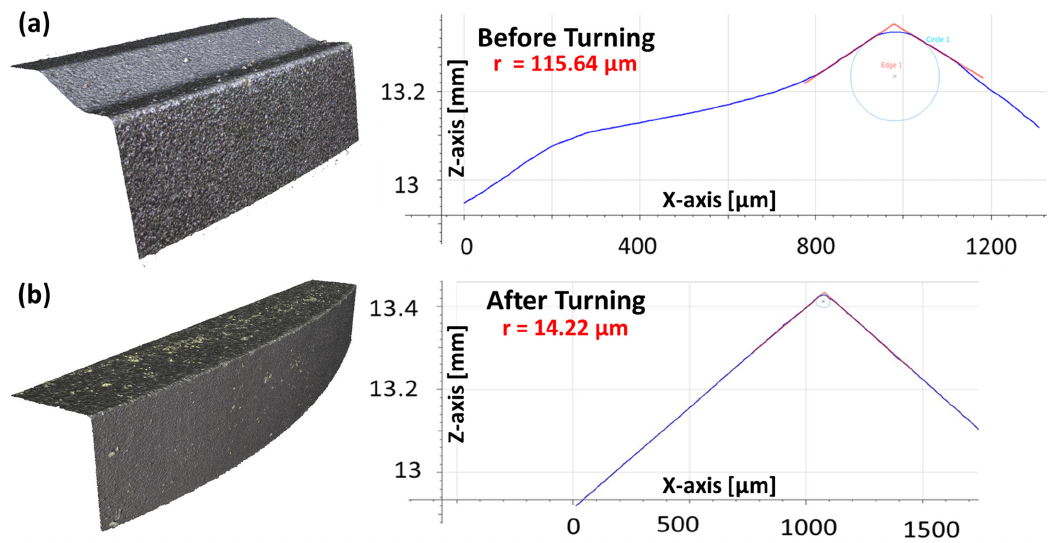
Figure 16. The edge profile comparison between the ( a ) non-machined and ( b ) optimally turned ZnO ceramic.